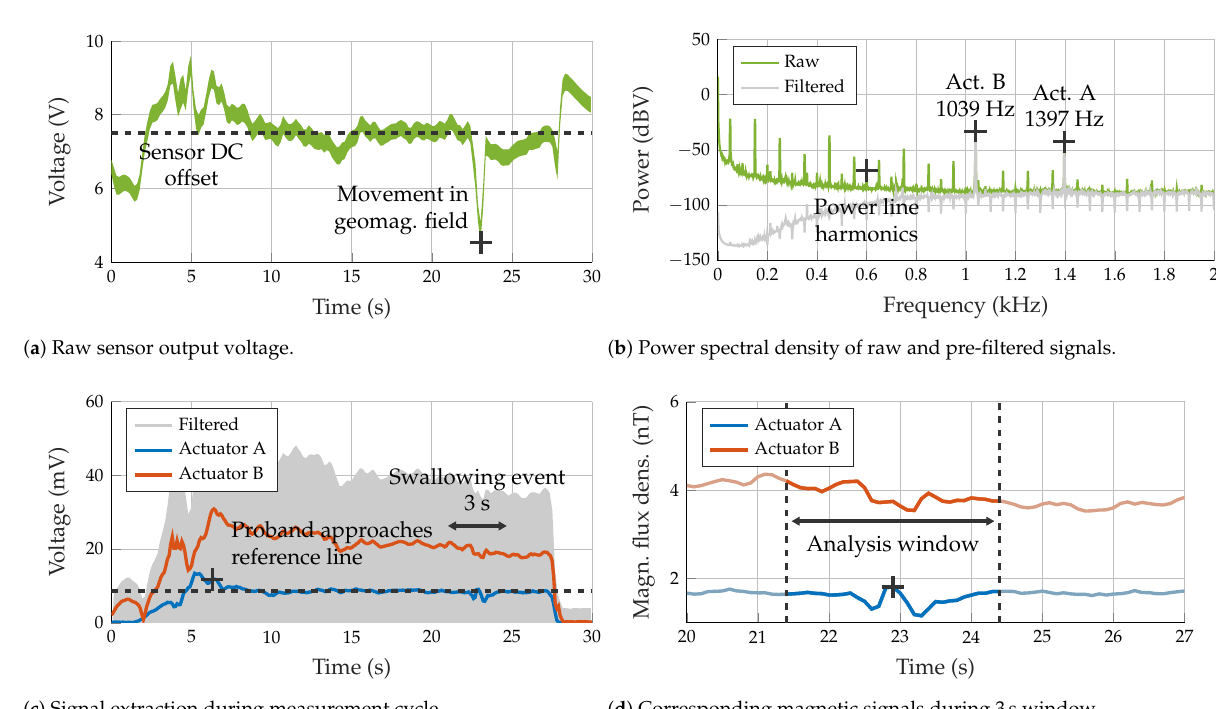
( d ) Corresponding magnetic signals during 3s window. Figure 3. Functional overview of the signal enhancement pipeline. Figure 3. Functional overview of the signal enhancement